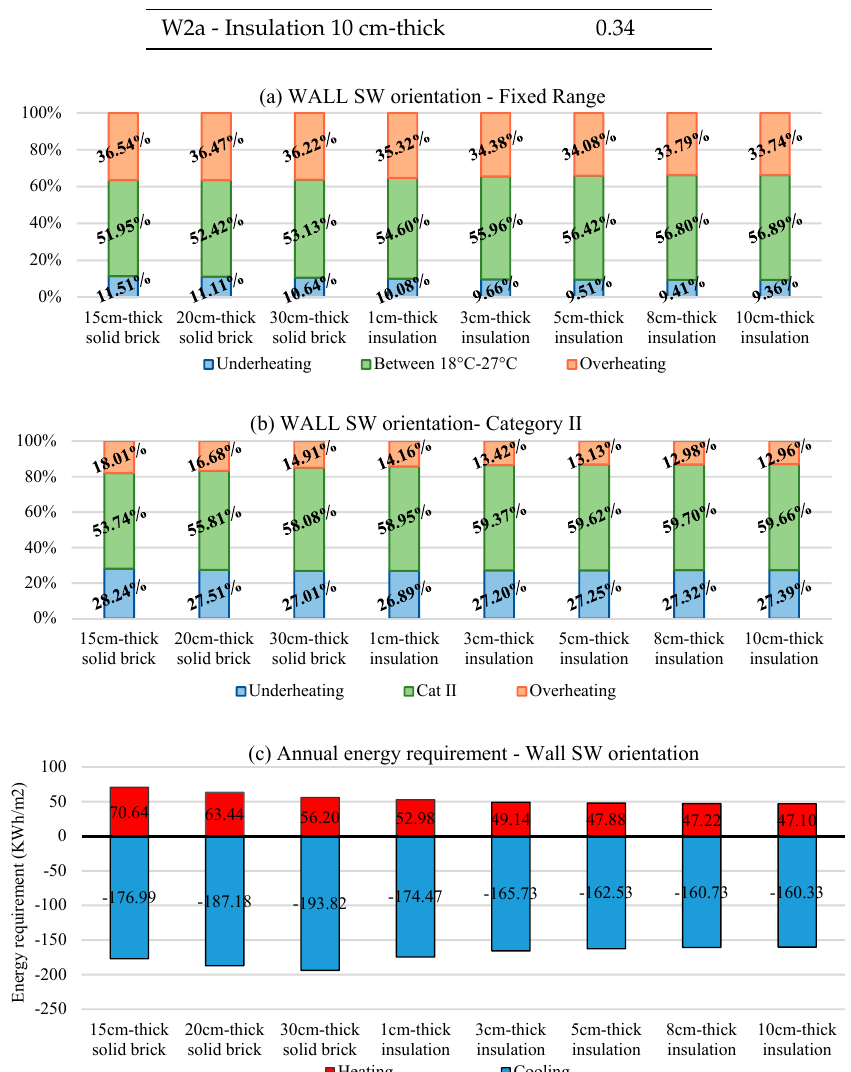
Figure 13. Comfort rates according to the static ( a ) and the adaptive ( b ) approach and annual energy requirement ( c ) for the wall W2 with SW orientation according to different insulation thicknesses.